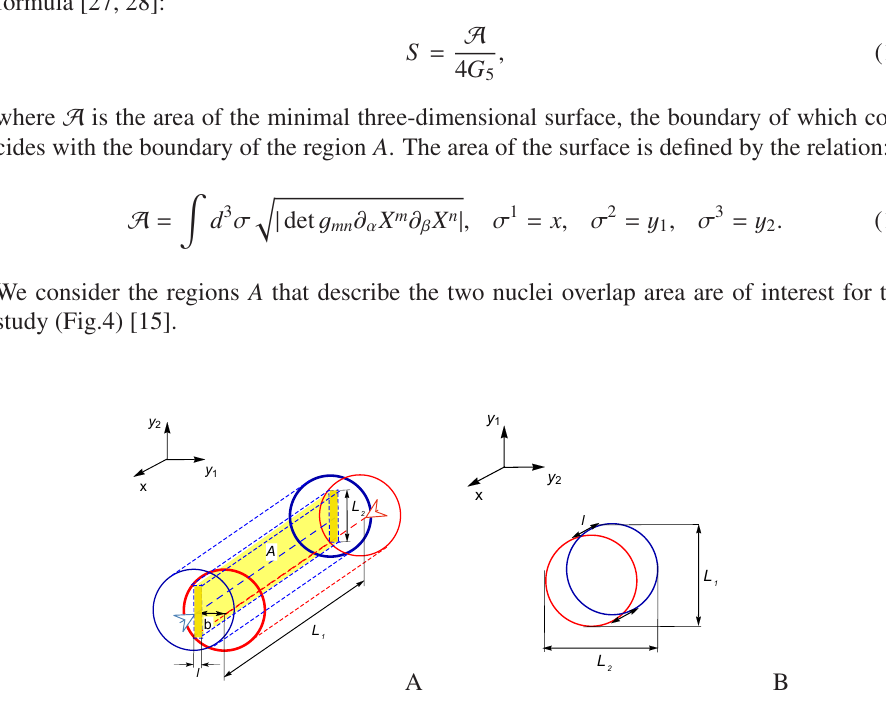
Figure 4. Schematic picture of HIC. Ions are presented as disks with diameter D (blue and red disks). A) The overlapping area for a peripheral collision is approximated by the parallelepiped with sides L 1 , L 2 and (cid:30) , L 1 , L 2 >> (cid:30) B) The overlapping area is almost cylinder and the case of very short time after collision is considered, (cid:30) << D , L 1 , L 2 2 ( z ) for the di ff erently oriented spatial, temporal Figure 3. The comparison of the e ff ective potentials V Wilson loops and HEE calculated in model [1] for µ = 0, c = 1, di ff erent z h and ν . −